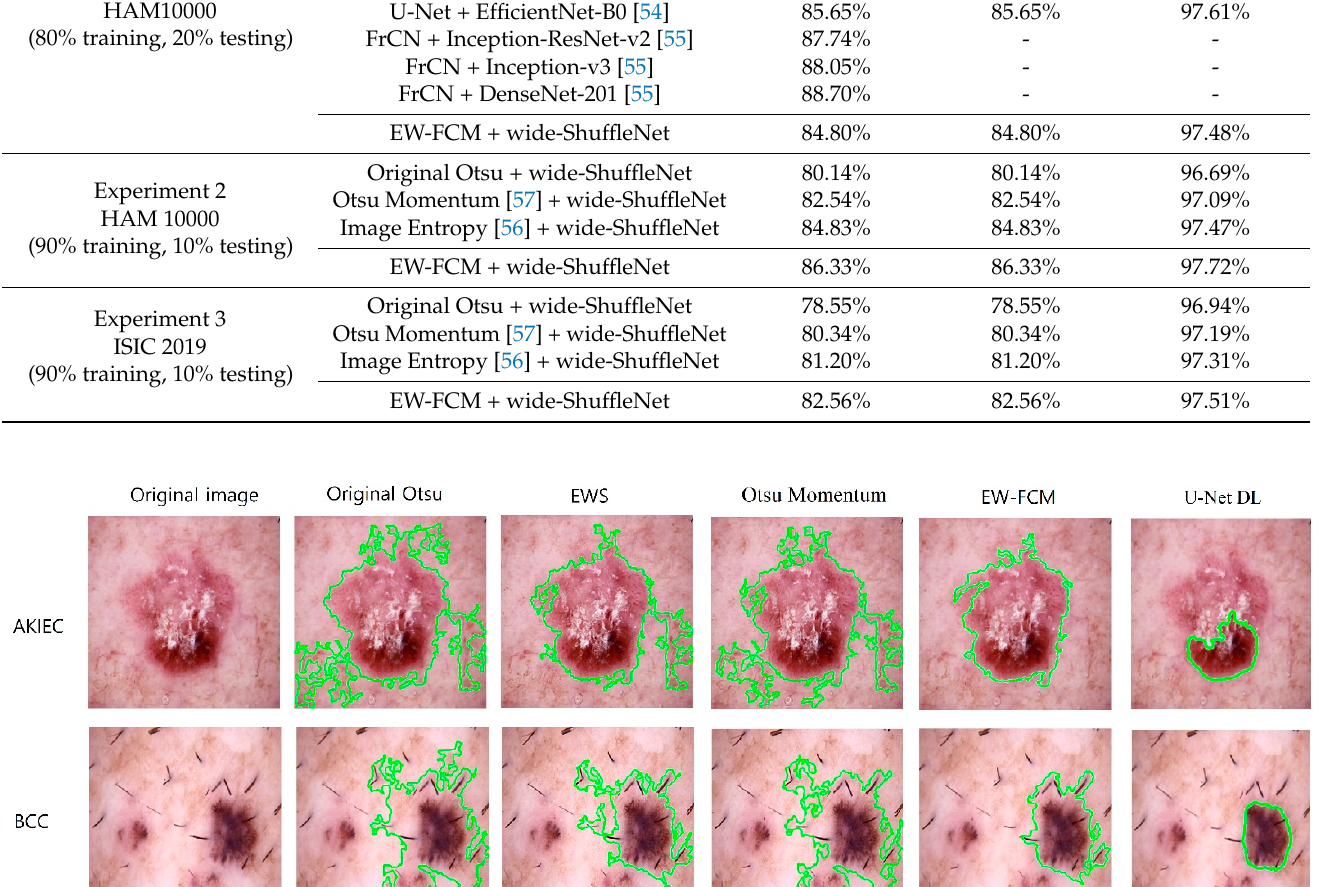
Table 6. Comparison with different methods on the ISIC2019 dataset in the third experiment (micro- average).